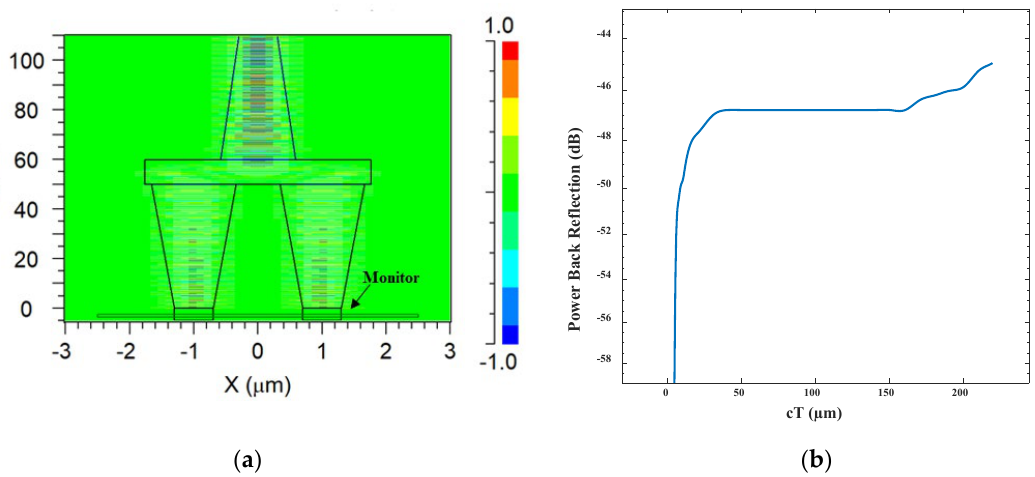
Figure 7. FDTD simulation setup: ( a ) schematic sketch of the FDTD setup; ( b ) the calculation of the back reflection based on FDTD simulation setup.